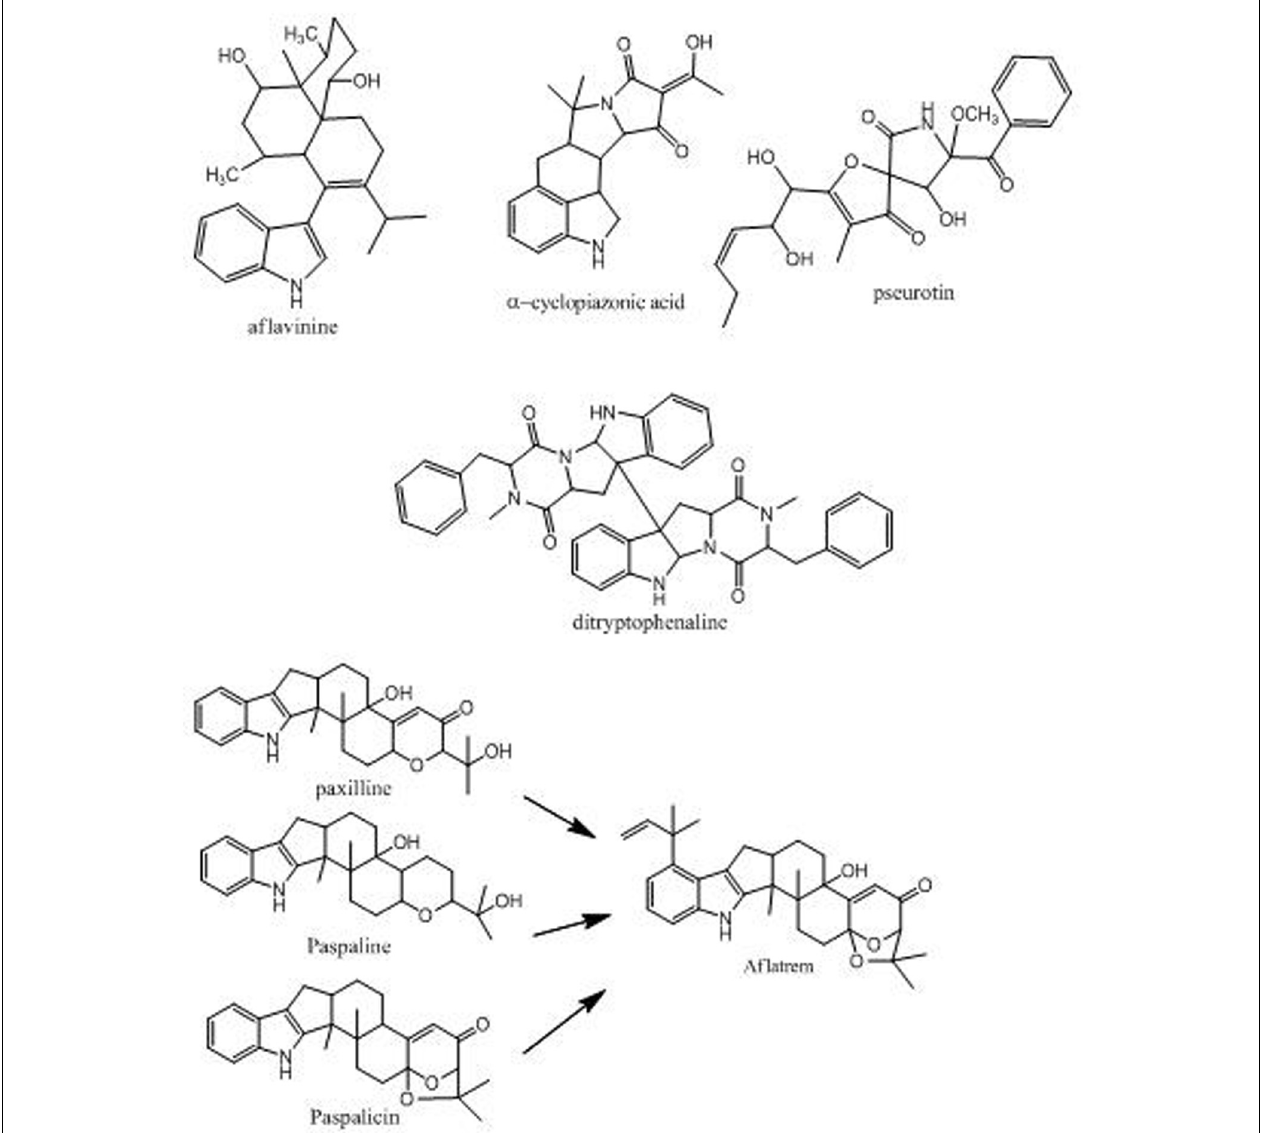
FIGURE 2 | Some known non-aflatoxin metabolites from A.